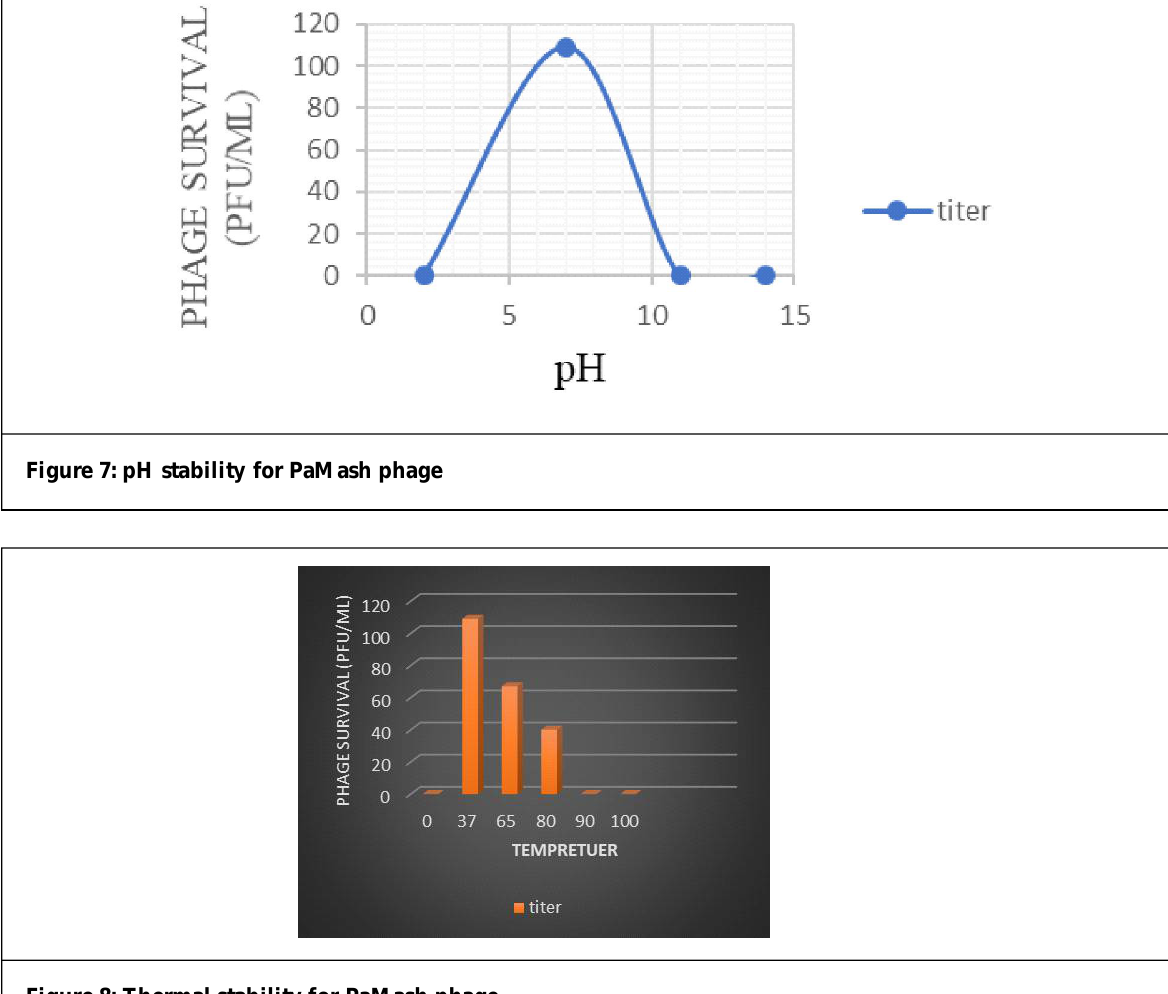
Figure 8: Thermal stability for PaMash phage